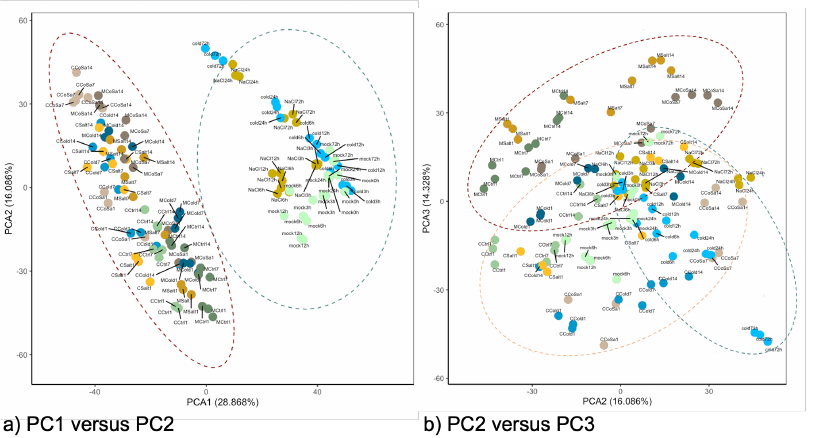
Figure A15. PCA from a combined analysis of Mazurka and CAP1035 in comparison with published data from Kang et al. RNASeq reads were mapped to an artificial transcriptome comprimising transcriptomes coming from Mazurka (M) and CAP1035 (C) and Kang et al. (lighter colors) [59] (see also methods). Shown in a) is the principal component 1 (PC1) versus principal component 2 (PC2), indicating that the highest variation in the combined analysis is coming from the two different studies/species (red eclipse: our data, grey eclipse: Kang et al. data). In b), the principal component 2 (PC2) is shown over principal component 3 (PC3), indicating that the next level of variation is influenced by the species (starting M versus starting C, red eclipse: Mazurka data, orange eclipse: CAP1035 data, grey eclipse: Kang et al. data). Control samples (Ctrl) are indicated in green, cold samples (Cold) in blue, salt samples (Salt) in orange, and samples with a combination of salt and cold (CoSa) in brown.